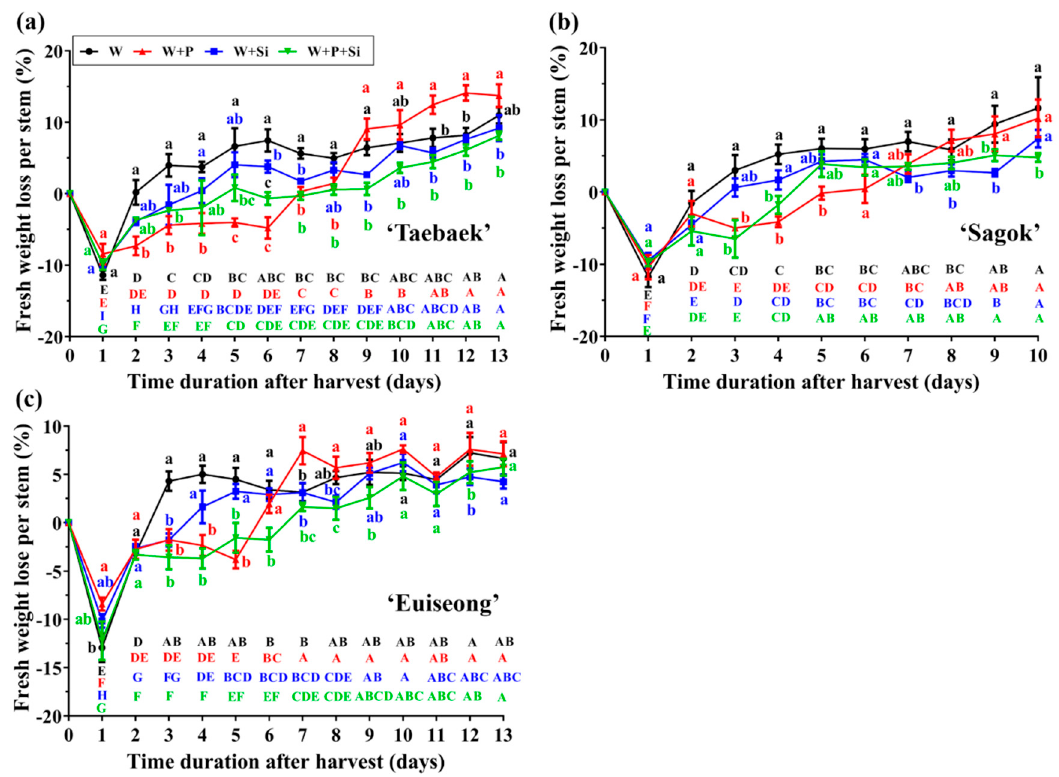
Figure 4. Effects of the four treatments on the fresh weight loss of the three cultivars, namely ( a ) ‘Taebaek’, ( b ) ‘Sagok’, and ( c ) ‘Euiseong’. Data presented are the mean ± SE of n = 9 replicates. Different lowercase letters indicate the differences in fresh weight lose among treatments on the same day after harvest; different capital letters indicate the differences in fresh weight loss of same treatment on different days after harvest (one-way ANOVA with Duncan’s multiple comparison range test at p = 0.05).